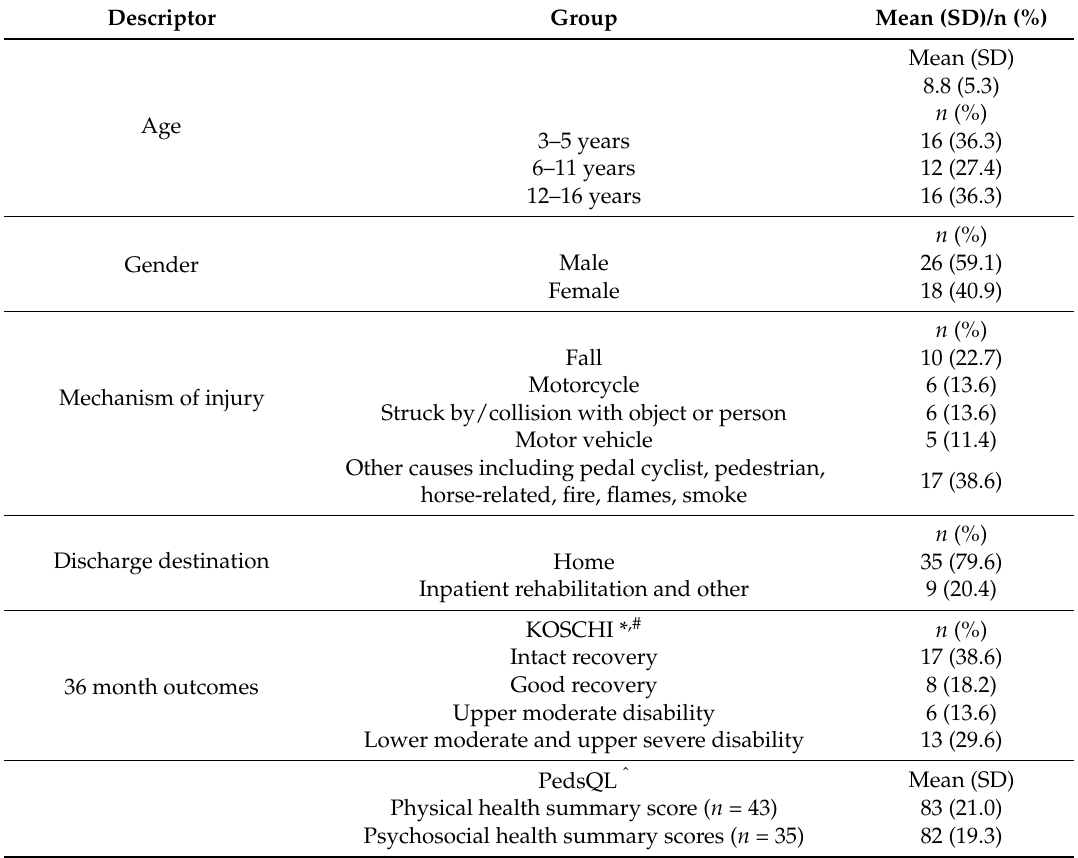
Table 2. Characteristics of child